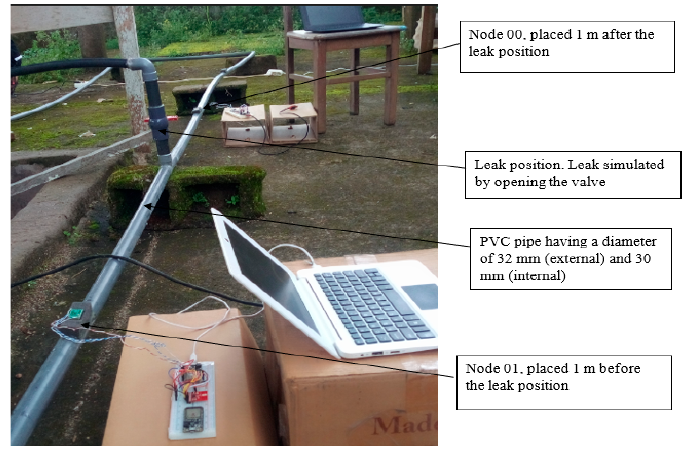
Figure 5. Setup of the laboratory testbed.